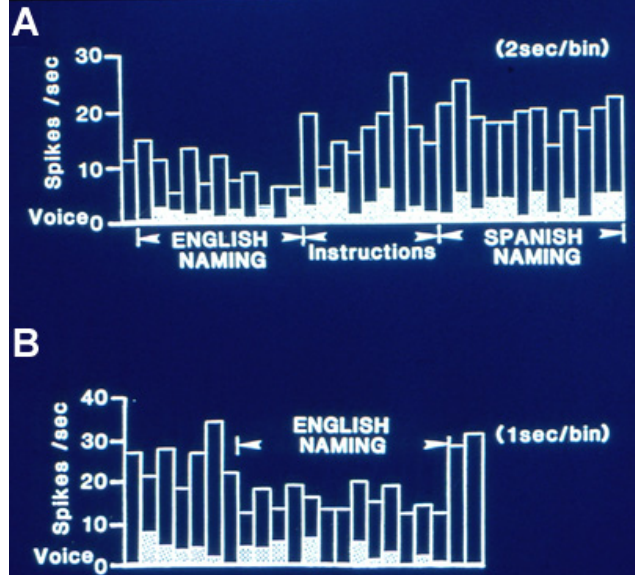
Figure 1. Single neuron activity from left, dominant superior temporal gyrus during overt naming of the same object pictures in two languages, English and Spanish. ( A ) Activity in 2 s bins during English naming. That shifts to a higher level with the instruction to name the same pictures in Spanish. Activity then continued at the same high level for some minutes during English and Spanish reading and the spatial matching tasks to the naming and reading slides. ( B ) Activity, now shown in 1 s bins, then abruptly decreased again during repeat naming in English, returning to the higher level on its completion. This recording illustrates the relative inhibition with naming characteristic of dominant temporal cortical activity, and the differential activity with the same linguistic task in different languages. Adapted from